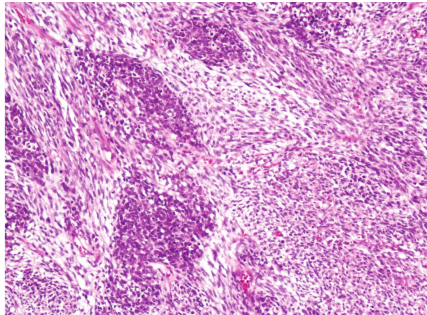
Figure 5: Nodules of blastema-like cells separated by loose tissue. H&E: × 100.